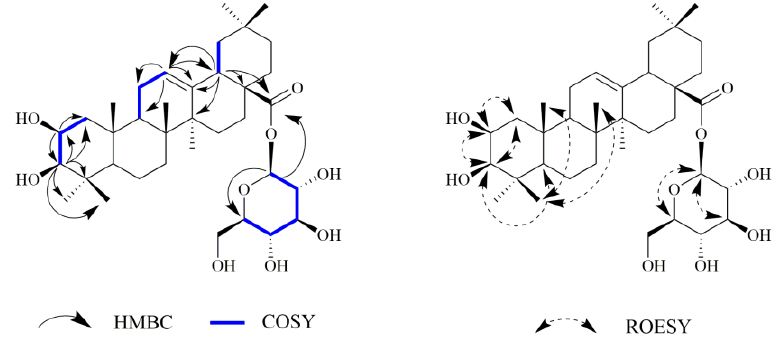
Figure 3. Key HMBC, COSY, and ROESY correlations of compound 3 .